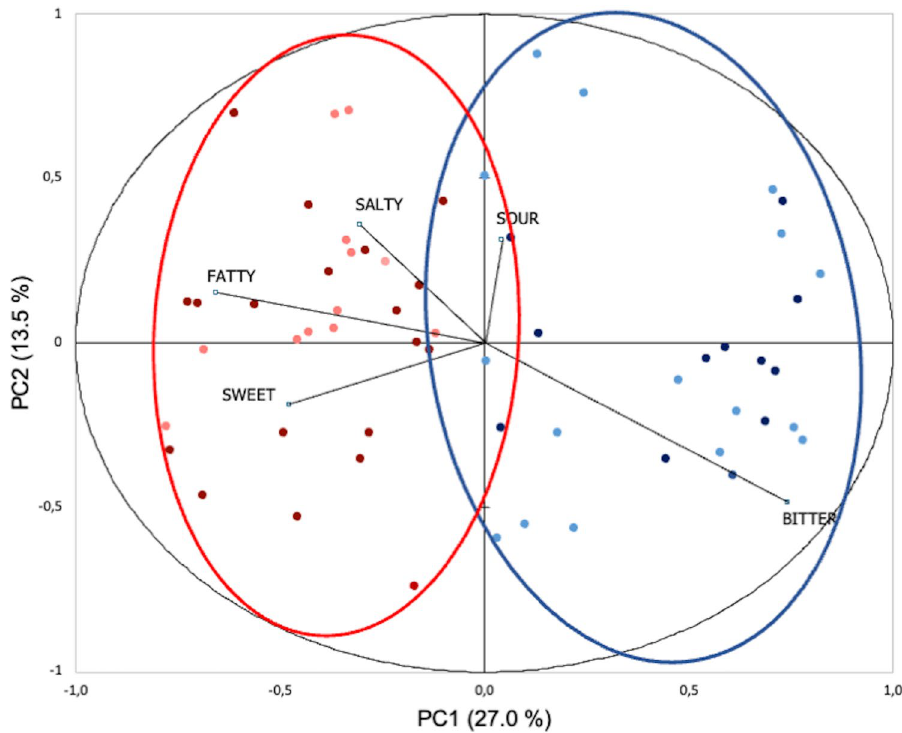
Figure 2. Loading from PC1–PC2 of the double-centered PCA on food liking resulting in two taste-liking clusters of Sweet-Salty-Fatty Likers (n = 31) and Bitter-Sour Likers (n = 28). Dot in dark colors (red and blue) depicted the children in the control group while dot in light colors (pink and light blue) depicted allergic